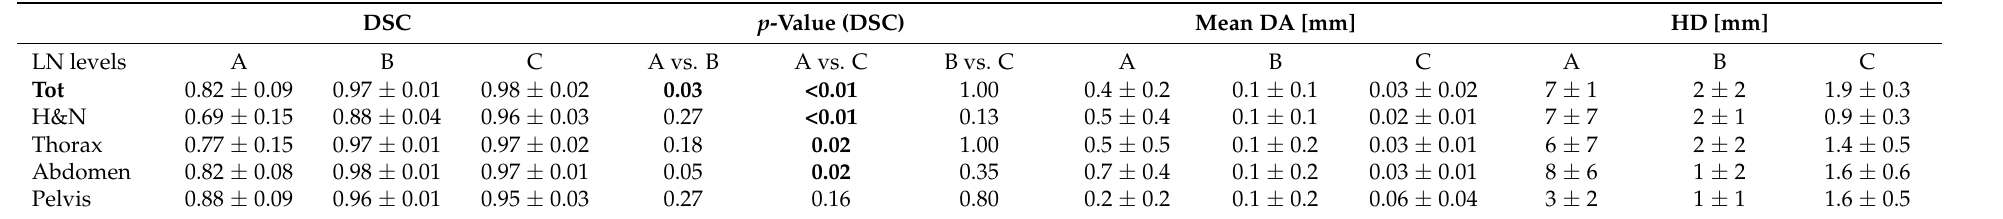
Table 4. Topological analysis of CTV_LN for each comparison group: (A) before vs. after guidelines’ introduction; (B) interobserver variability; (C) intraobserver